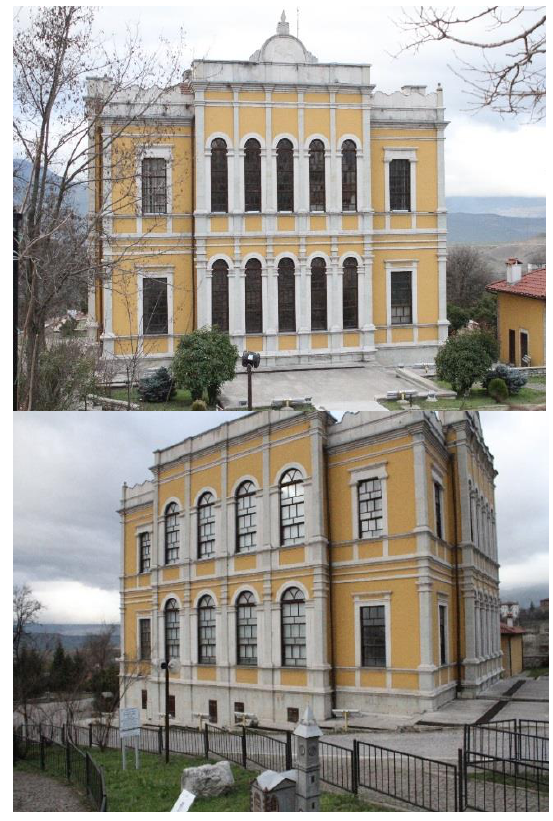
Figure 1. Historical Musium of Safranblue (test